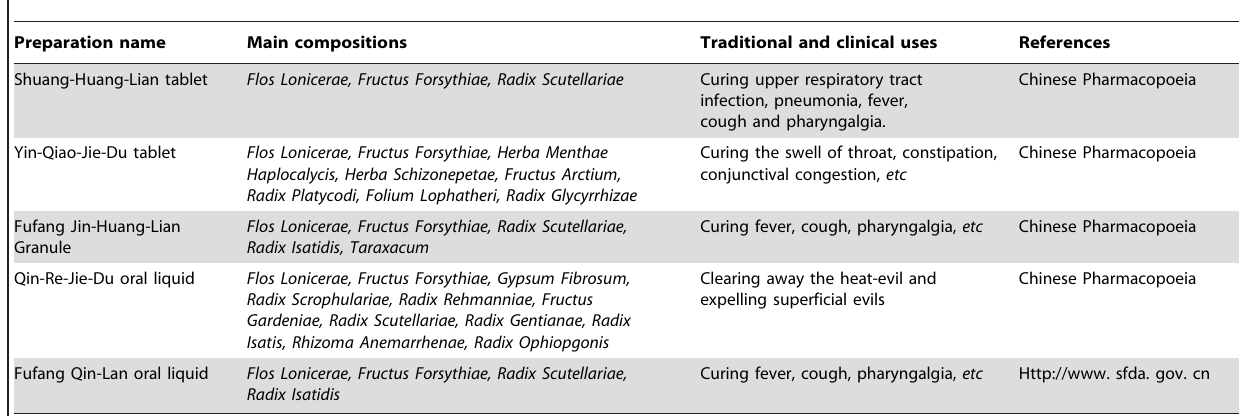
Table 1. The traditional and clinical uses of Flos Lonicerae - Fructus Forsythiae herb couple